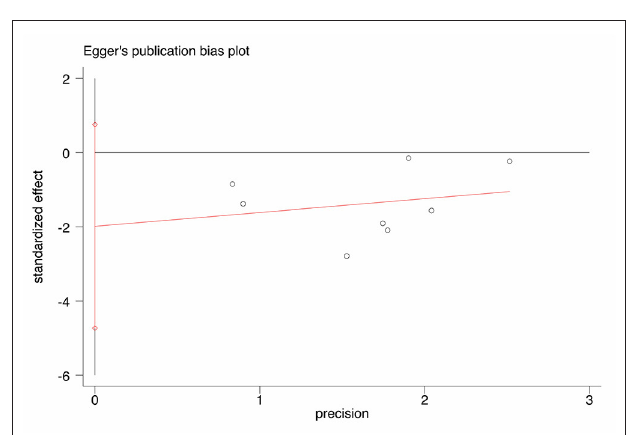
FIGURE 7 | Egger’s funnel plot for publication bias.